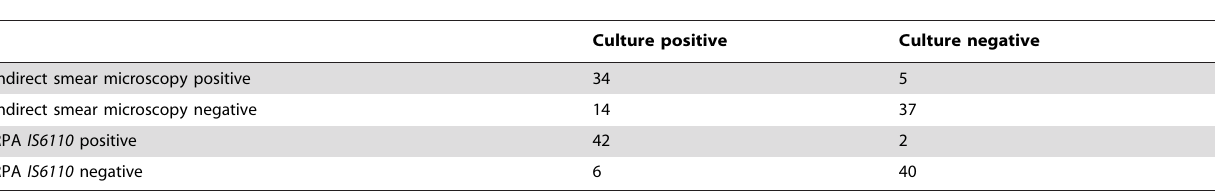
Table 4. Tuberculosis detection by indirect smear microscopy vs RPA IS 6110 .